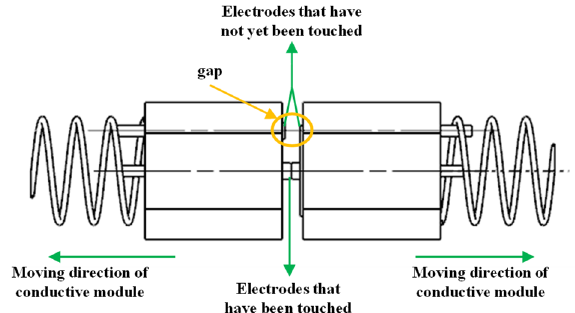
Figure 16. Interference of electrode position.